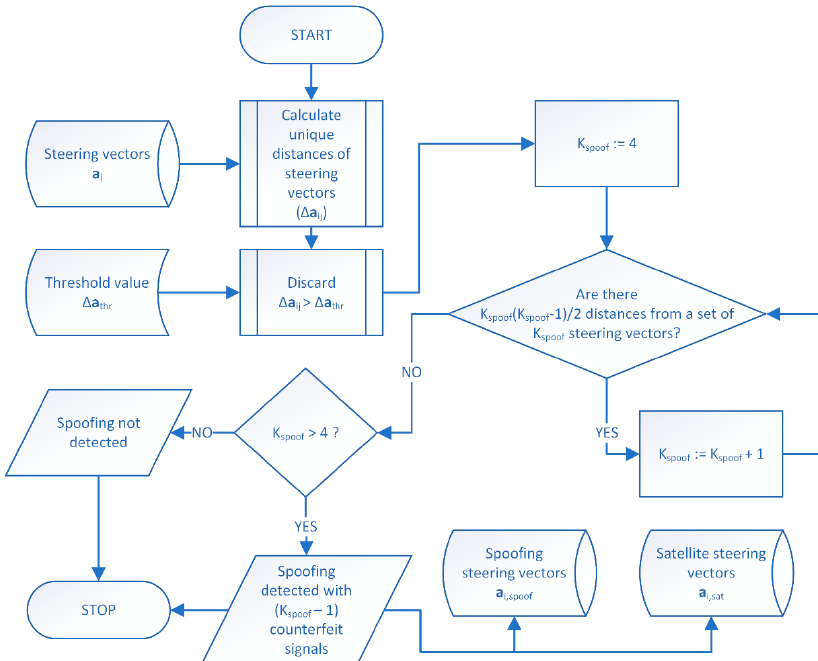
Figure 3. GNSS spoofing detection